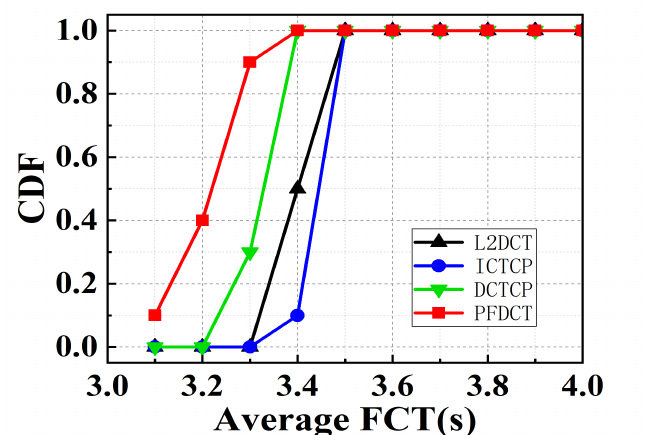
Figure 8. The average FCT with varying link